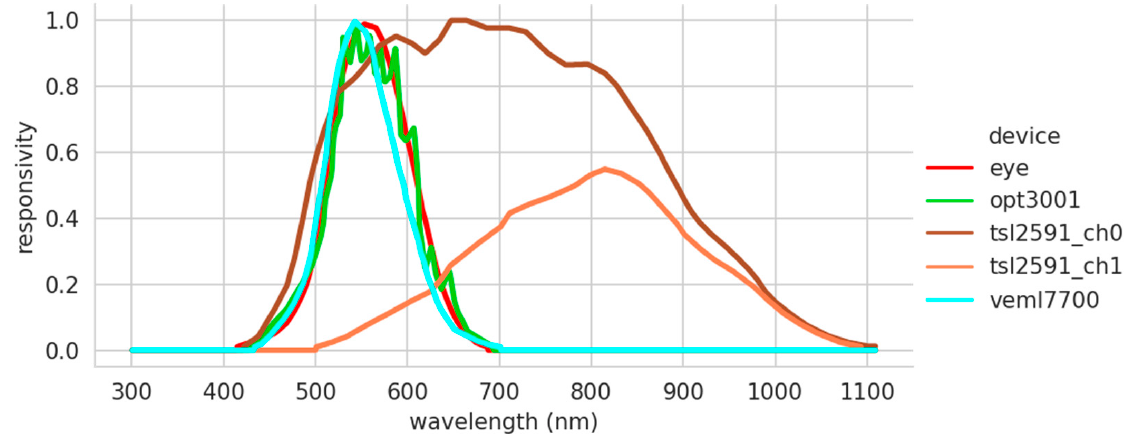
Figure 2. Spectral response of human eye and selected sensors.